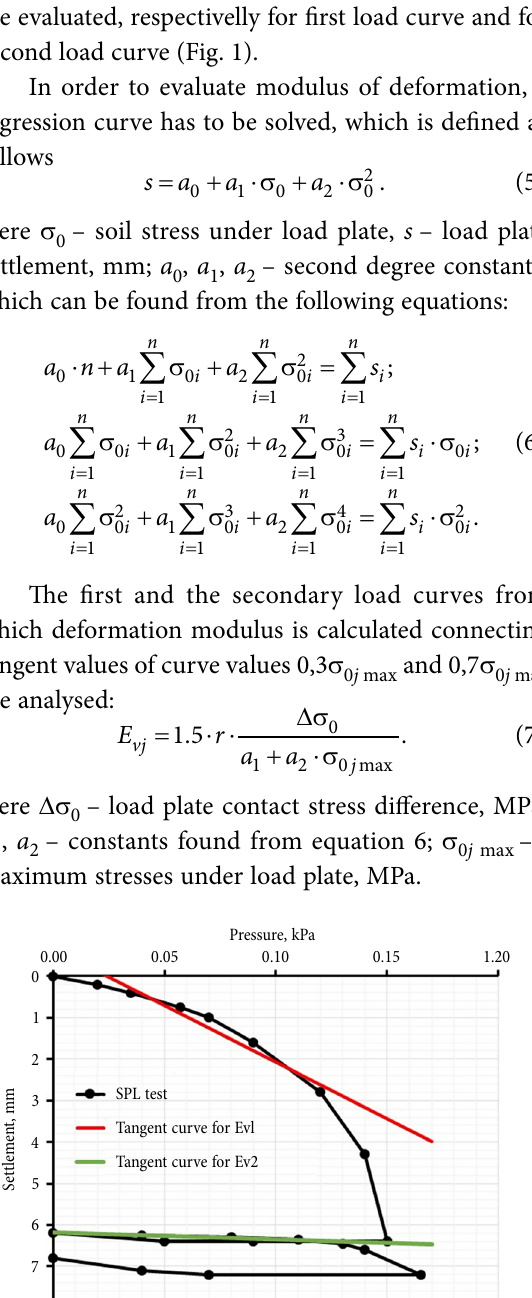
Fig. 1. Pressure settlement curve from SPL test